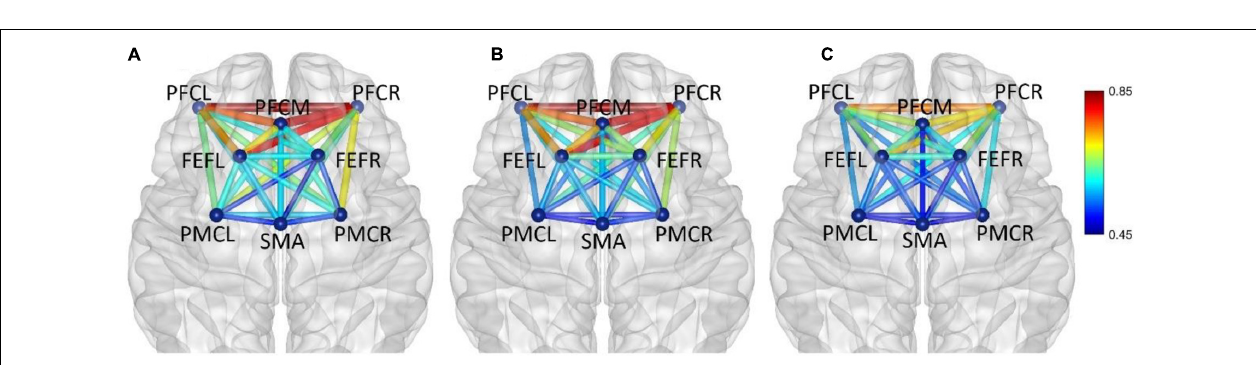
FIGURE 9 | In frequency band V (0.6–2.0 Hz), non-fatigue (A,B) moderate fatigue, and (C) severe fatigue. The average cortical functional connectivity network contains eight ROI brain regions. The width and color of the line represent the strength of the connectivity.